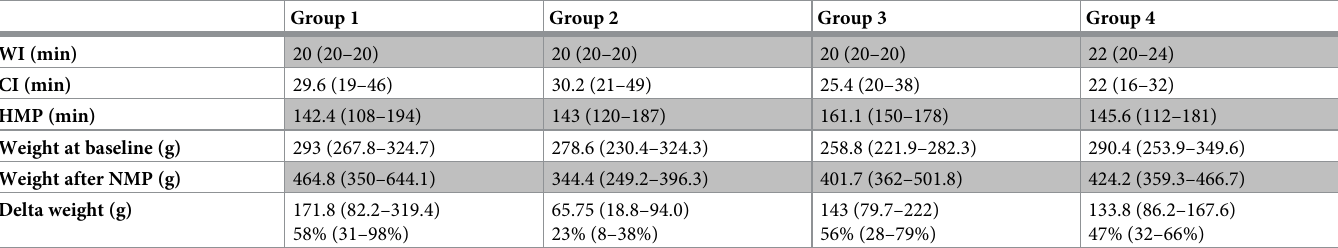
Table 2. Baseline information.